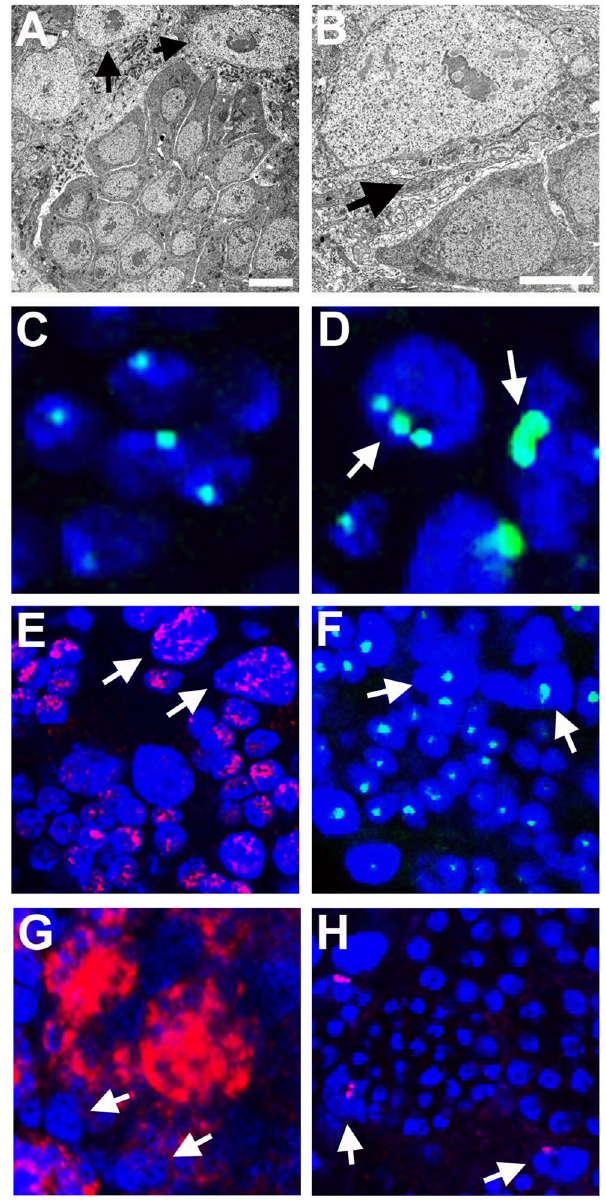
Figure 7. Nuclear characteristics of trophocytes. ( A ) Trophocytes (black arrows) adjacent to cystocytes in the testis of a yellow male pupa. ( B ) High magnification of a trophocyte (top of panel) located adjacent to cystocytes (bottom). Some physical space separates the plasma membranes of these cell types (black arrow). ( C ) A cyst of germ cells stained for rDNA (green); each cystocyte has a single focus of rDNA. ( D ) Several trophocytes, each with multiple foci of rDNA, indicating polyploidy. ( E ) Both trophocytes and cystocytes stained for active RNA polymerase II (red). ( F ) Ribosomal RNA (green) is expressed in both cystocytes and trophocytes. ( G ) Transcripts of the germ-line determinant gene, vasa, are expressed only in cystocytes (red). ( H ) Non-coding transcripts expressed by the B chromosome, PSR, are expressed in trophocytes and not in cystocytes. White arrows in panels (D) through ( H ) point to